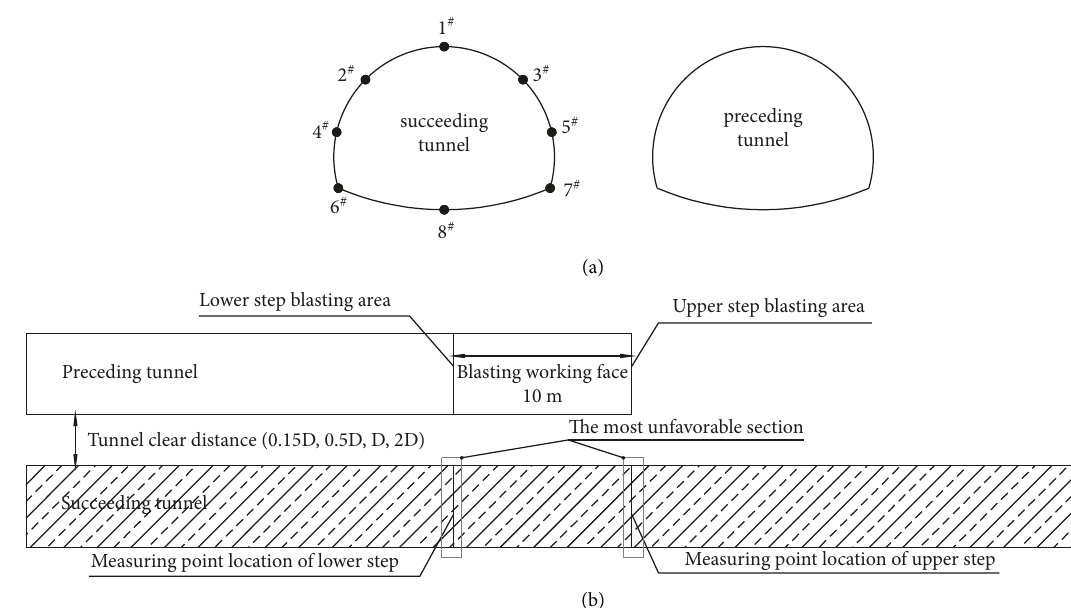
Figure 14: Schematic diagram of measuring point layout. (a) The position of the cross section of the measuring point and (b) plane position of measuring point.